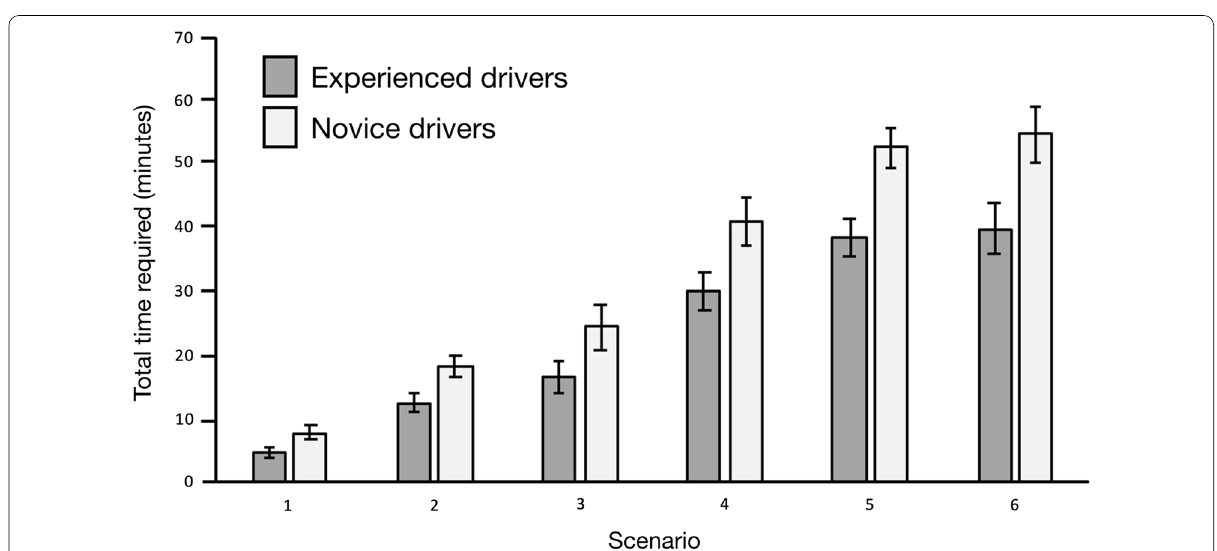
Fig. 4 Mean estimated total time required to complete each scenario (